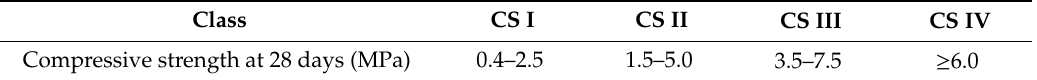
Table 10. Rendering and plastering mortar classes according to the compressive strength.